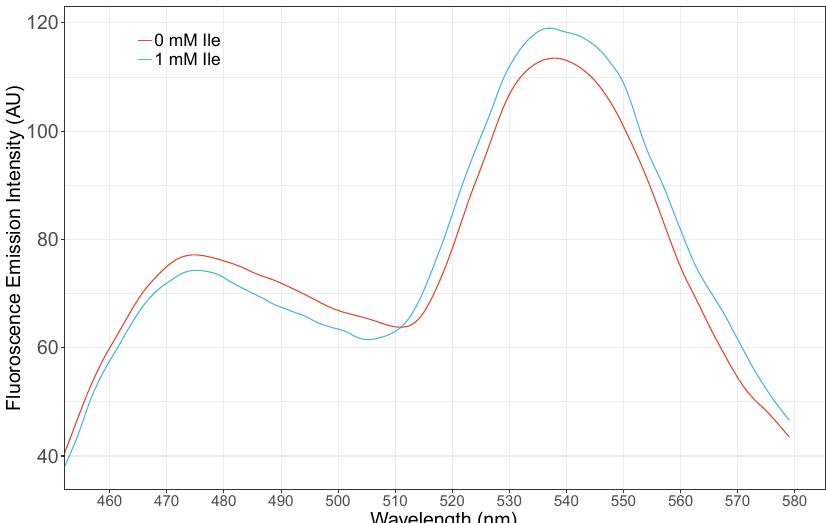
Figure 2. Fluorescence Spectral analysis of the GEII nanosensor. Change in the FRET ratio of the sensor was measured by using purified protein from bacterial cells in the absence and presence of 1 mM isoleucine. ECFP was excited at 435 nm and emissions from Venus recorded in the range of 480–535 nm.